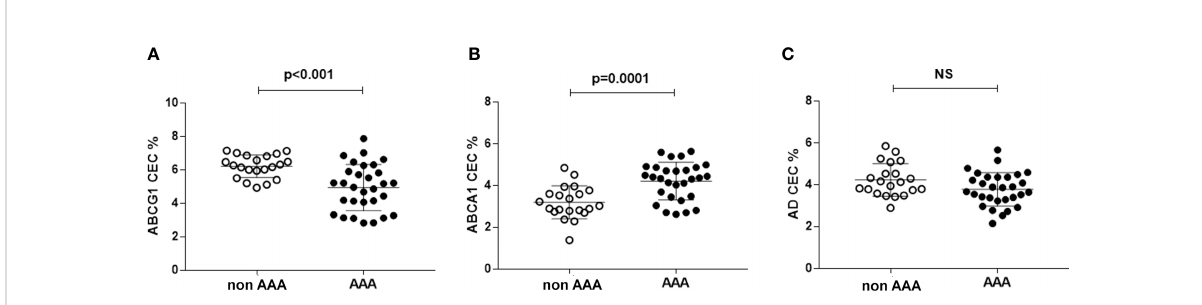
FIGURE 2 HDL CEC in AAA and non-AAA control patients. Panel (A) refers to ABCG1-mediated CEC; panel (B) refers to ABCA1-mediated CEC; panel (C) referes to AD-mediated CEC. The mean and SD for each group are reported. Unpaired two-tailed Student ’ s t-test for parameters with normal distribution was used. NS, not signi fi cant.